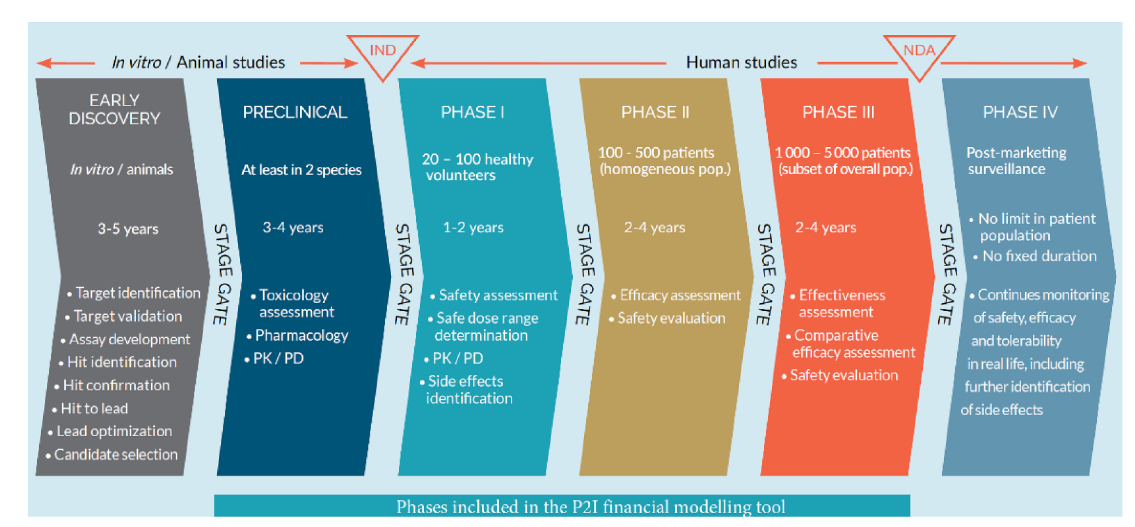
Figure 2. Development phases included in the P2I model. ND: investigational new drug application; NDA: new drug application; m: million; PK: pharmacokinetics (absorption, distribution, metabolism, excretion); PD: pharmacodynamics; pop.: population; P2I: Portfolio-to-Impact (adapted from Health Product Research and Development Fund: A Proposal for Financing and Operation 3 ).